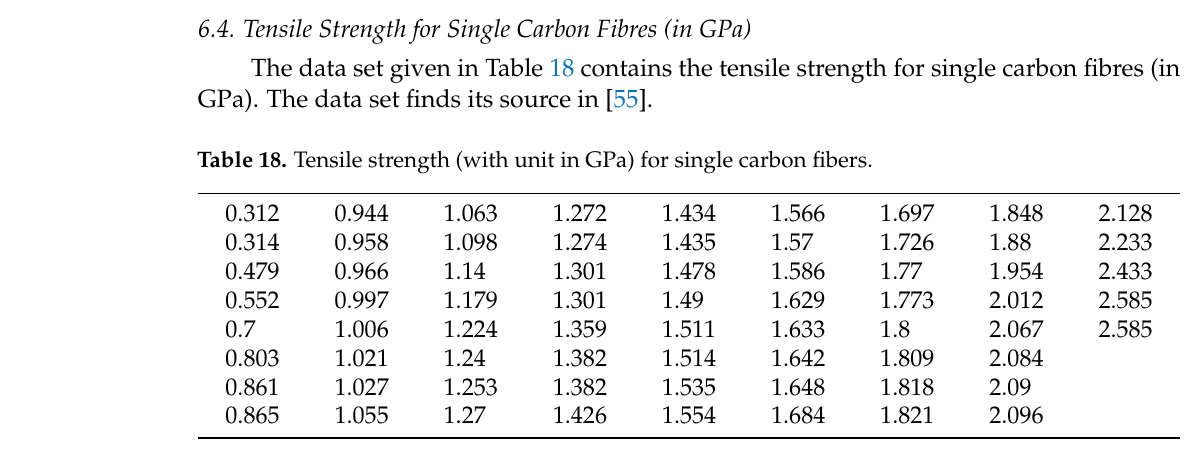
Figure 22. ACF test plots for parameters of TLMW model for waiting times.